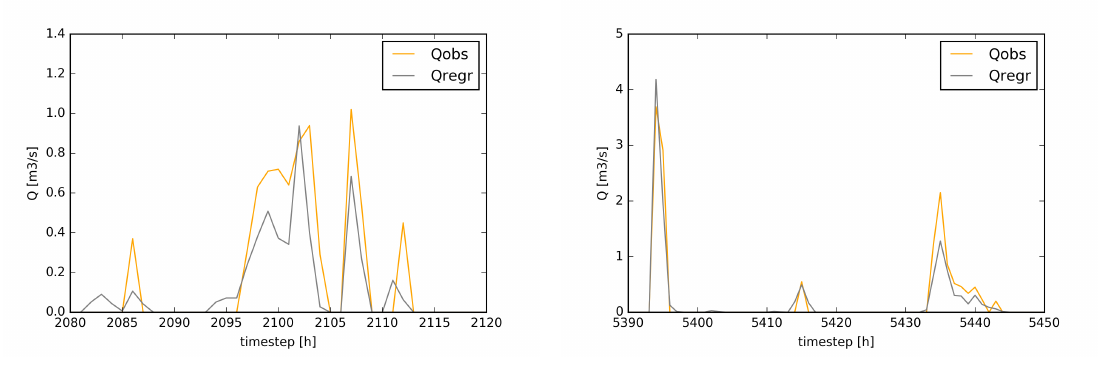
Figure 14. Discharge at the outlet, observed (yellow) vs. regressed (grey) for the Roodebeek catchment (20 m, 1 h) in ( a ) March and ( b ) August